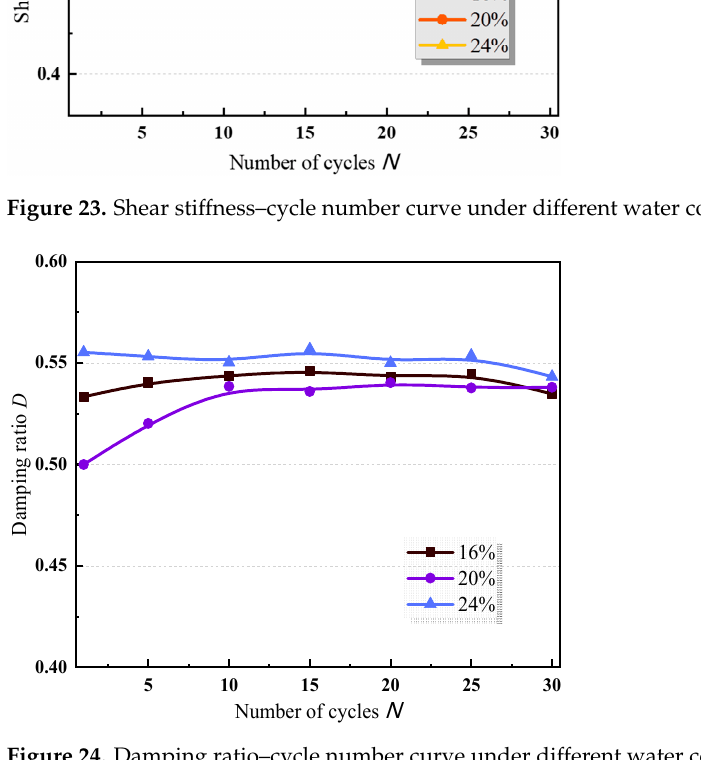
Figure 24. Damping ratio–cycle number curve under different water content conditions.